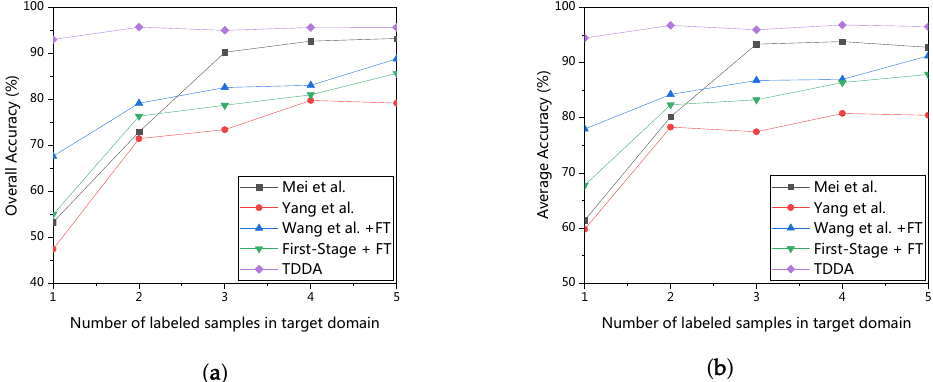
Figure 12. The classification results of different methods with different labeled samples in target domain on Shanghai → Hangzhou dataset. (a) OA. (b) AA.